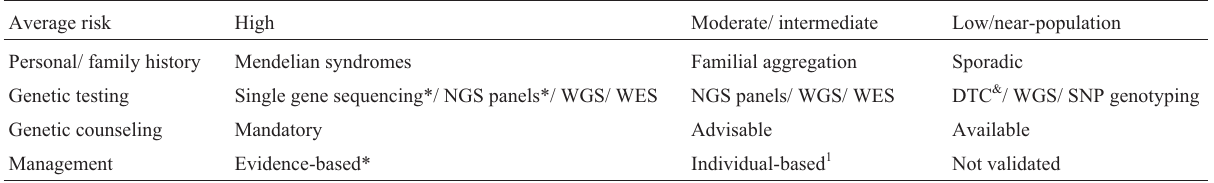
Table 1 - Overview of hereditary cancer risk